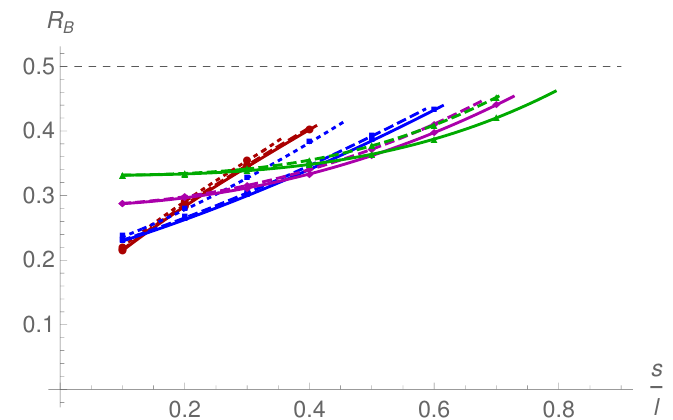
Figure 16 . Demonstration of weak monogamy in the S B phase as a function of s/l for various d and total widths L in the ( d + 1) -dimensional AdS black brane background. Notation of curves as in figure